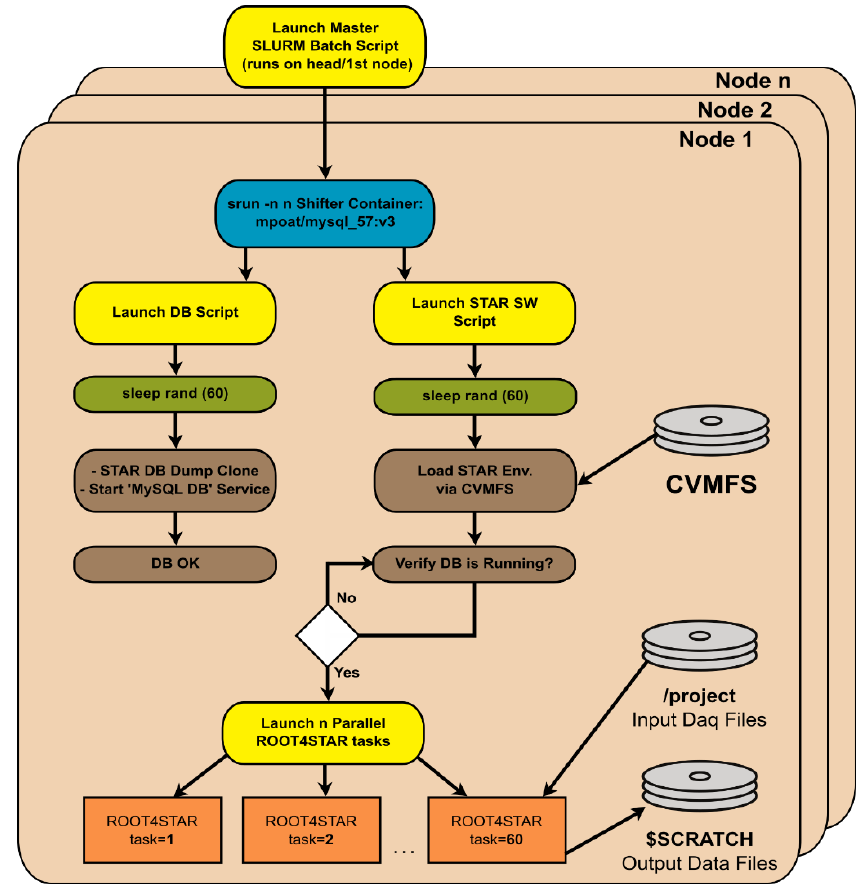
Figure 2. Diagram depicting our new workflow which starts at the Master SLURM Batch script, followed by launching the MySQL DB + R4S container and two parallel scripts (Load DB script & STAR Software Script). Once the DB is verified it is running from the STAR Software Script, we then launch parallel R4S tasks on the